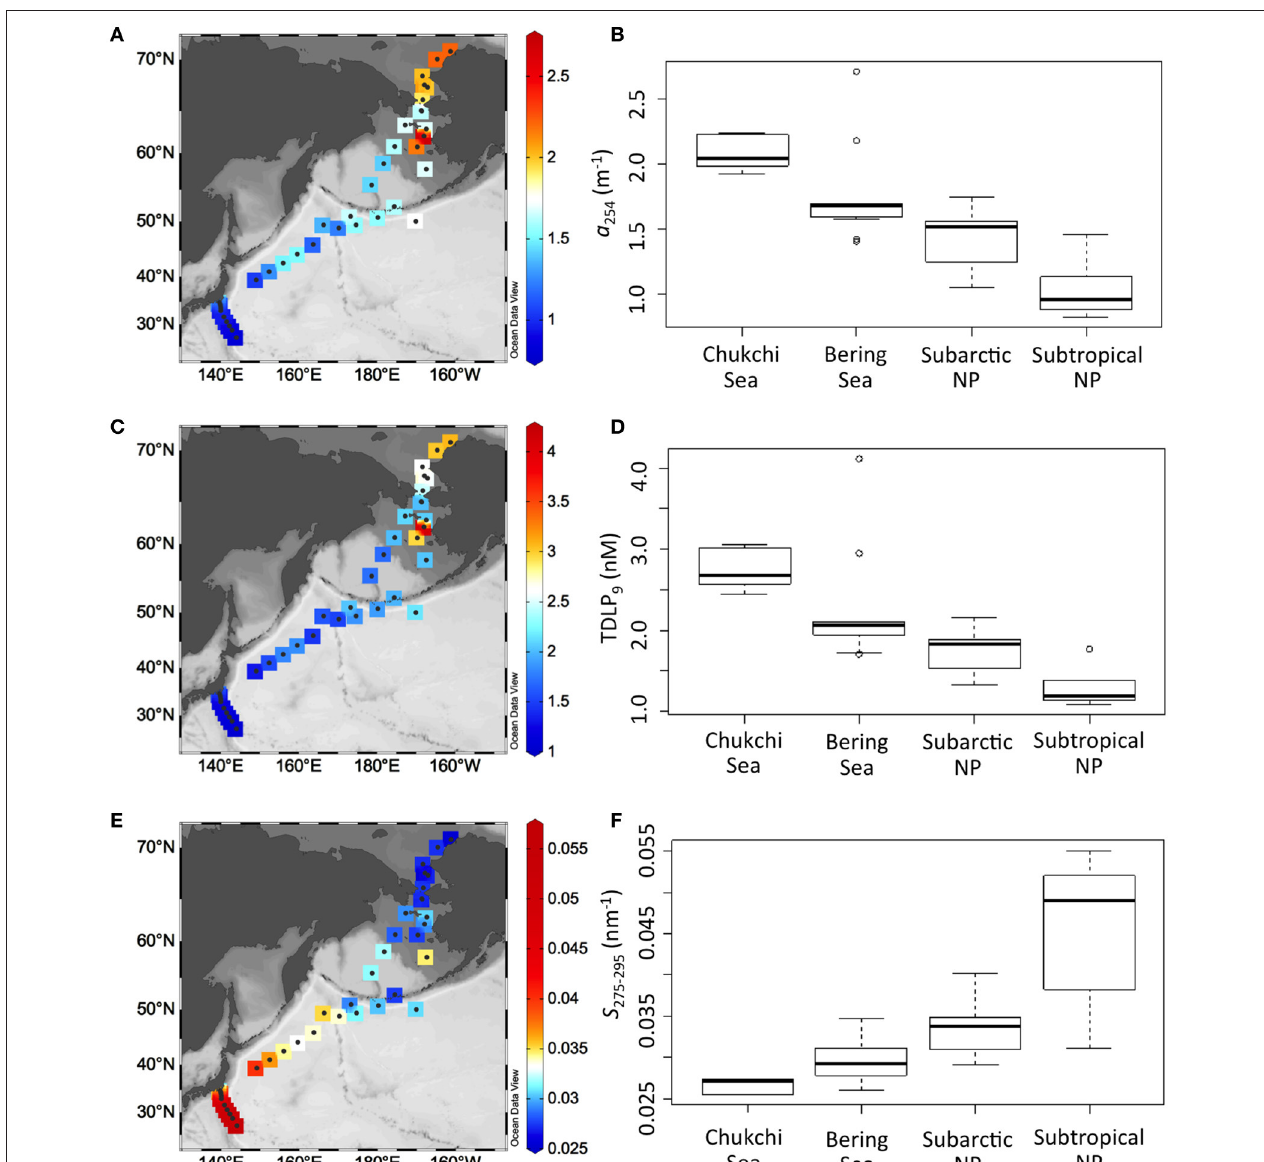
FIGURE 3 | Spatial distributions of a 254 (A) , TDLP 9 (C) , and S 275 − 295 (E) , and box and whisker plots of a 254 (B) , TDLP 9 (D) , and S 275 − 295 (F) in surface waters of the Chukchi/Bering Seas, subarctic, and subtropical North Pacific (NP). In box and whisker plots, the central bold line represents the median of the dataset. The upper and lower ends of the box represent the first and third quartiles of the dataset, respectively. The upper and lower whiskers represent the dataset maximum and minimum, respectively. The open circle represents the outlier (more than 2 standard